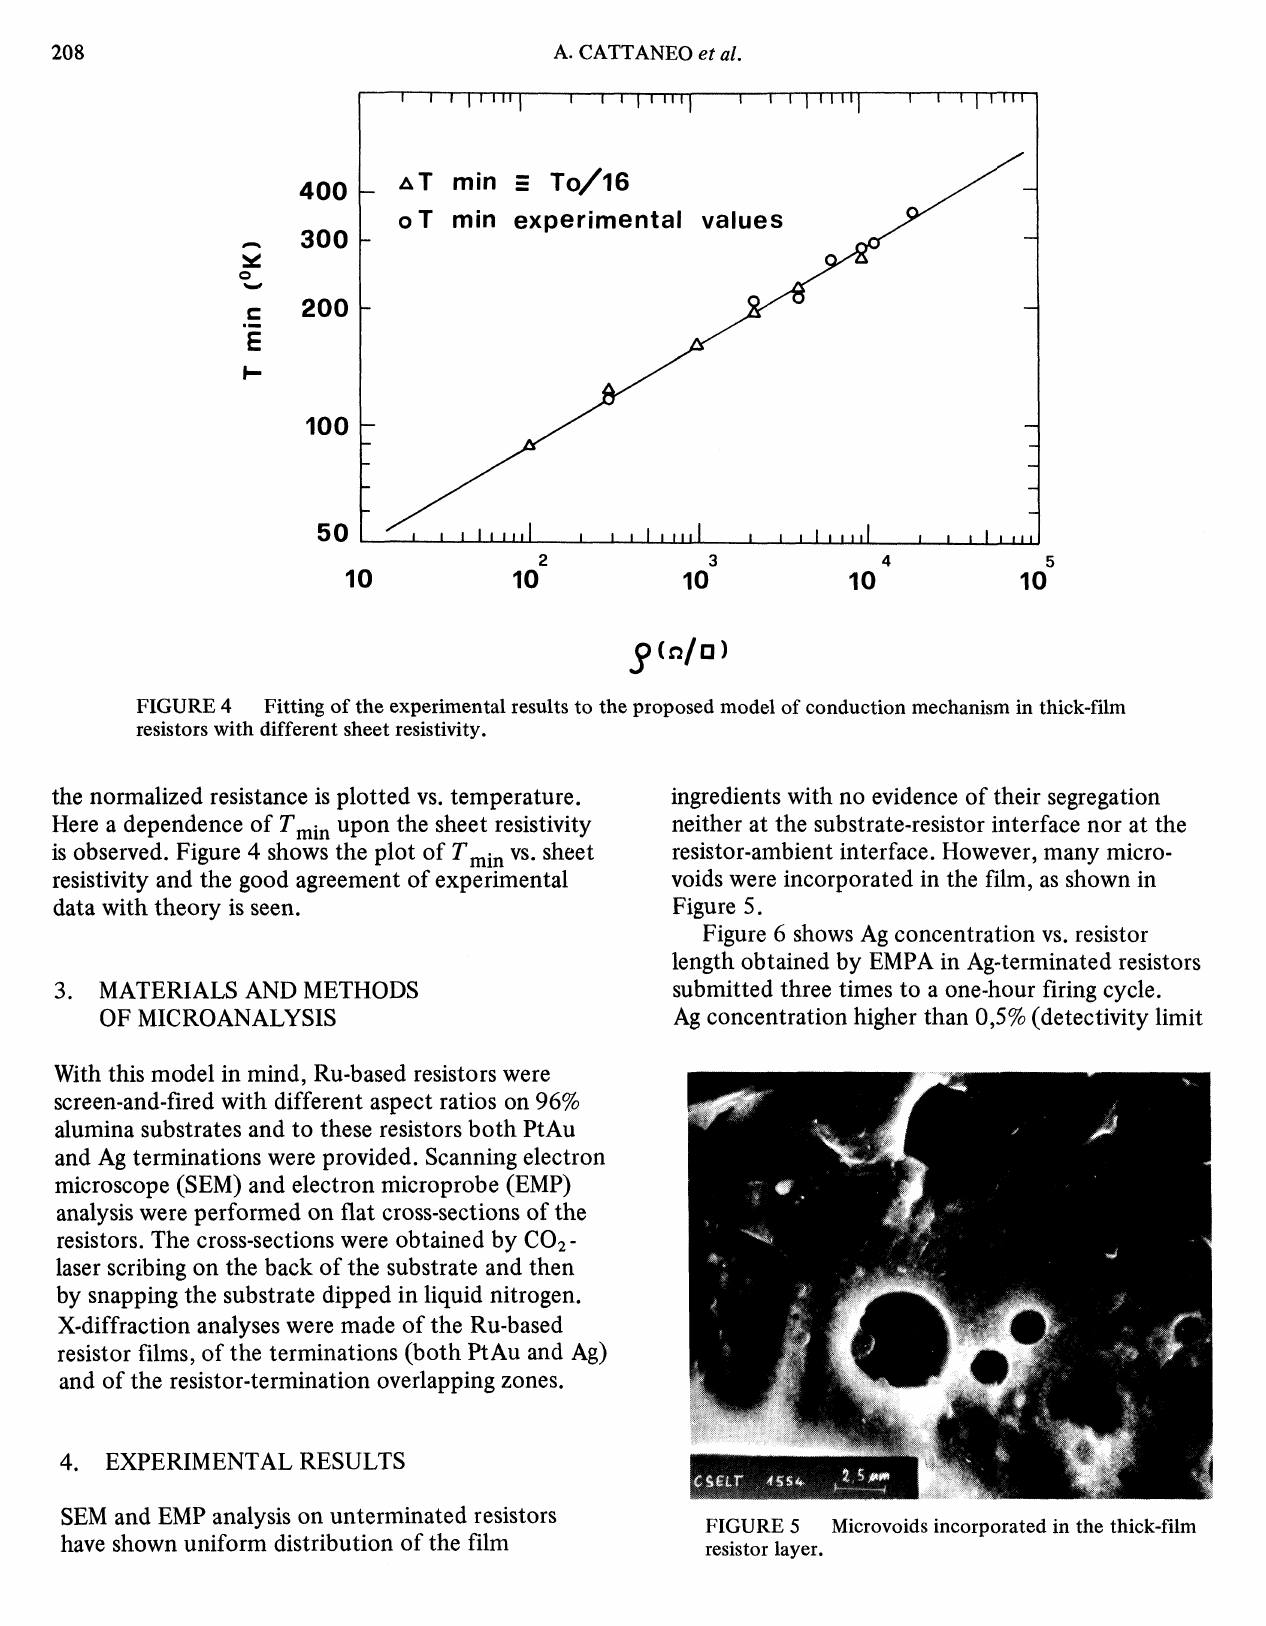
FIGURE 5 Microvoids incorporated in the resistor layer.